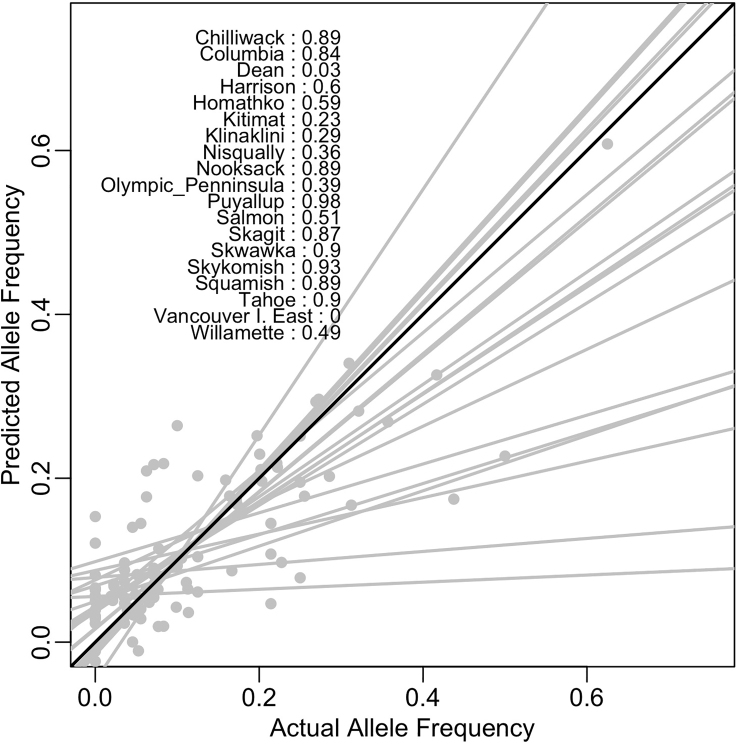
Predicted Minor Allele Frequencies under Past Climate Normals Plotted by Actual Current Minor Allele FrequenciesText shows the R2 of each population’s linear regression results. The black line indicates a 1:1 line, while gray lines are population-level fits.